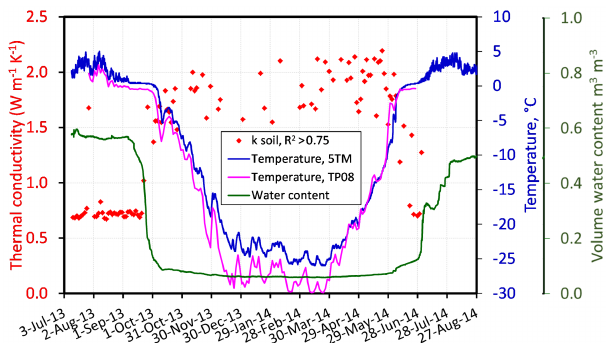
Figure 10. Seasonal evolution of the thermal conductivity, temper- ature and volume water content of the soil at 10cm depth for the 2013–2014 season. The 5TM probe which measures both tempera- ture and water content hourly is about 2m from the TP08 NP, which measures thermal conductivity and temperature every 2